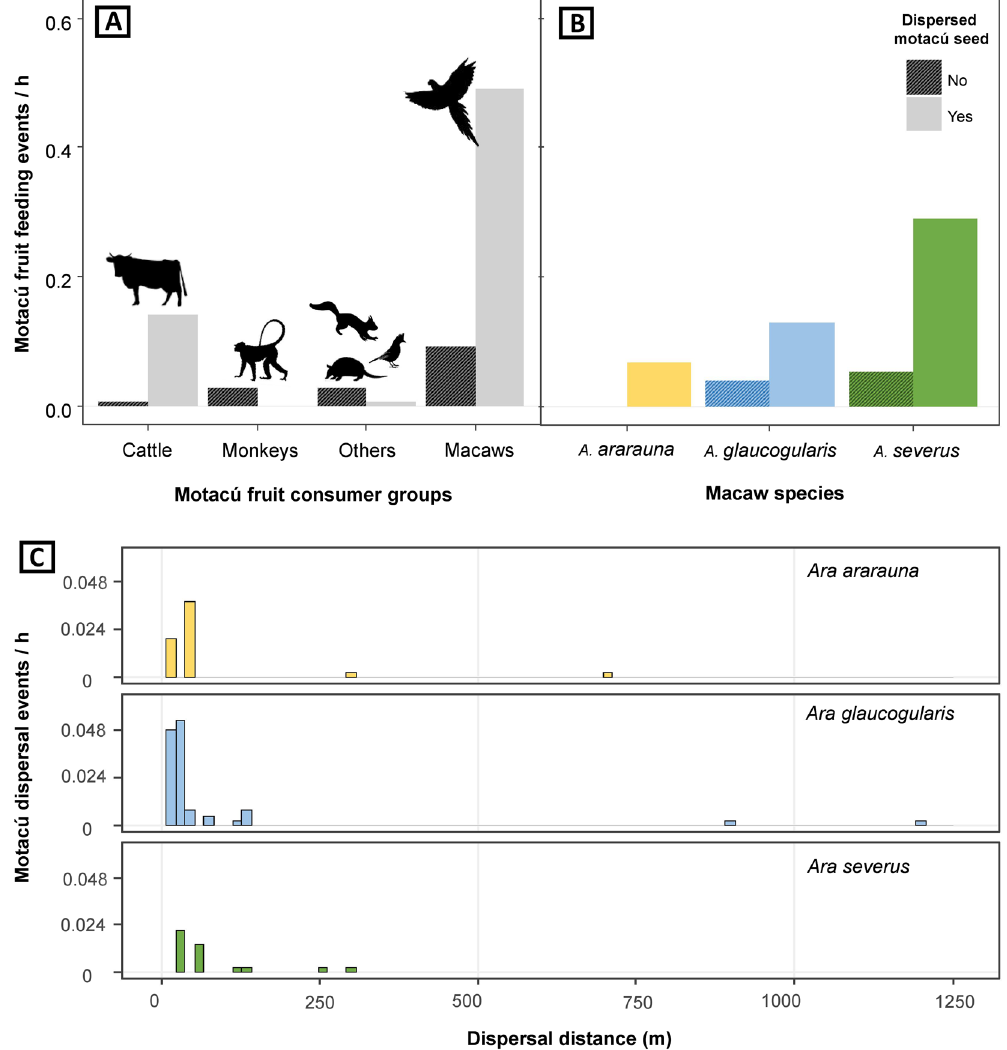
Figure 2. Consumption and seed dispersal rates of motacú palm. ( A ) Differential fruit consumption and seed dispersal rates of each animal group, ( B ) differential fruit consumption and seed dispersal rates of macaw species with some seed dispersion observed, and ( C ) frequencies of seed dispersal distances by each macaw